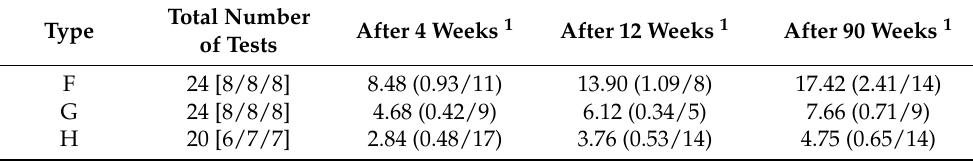
Table 4. Mortar DPT strength f m.DPT in MPa.